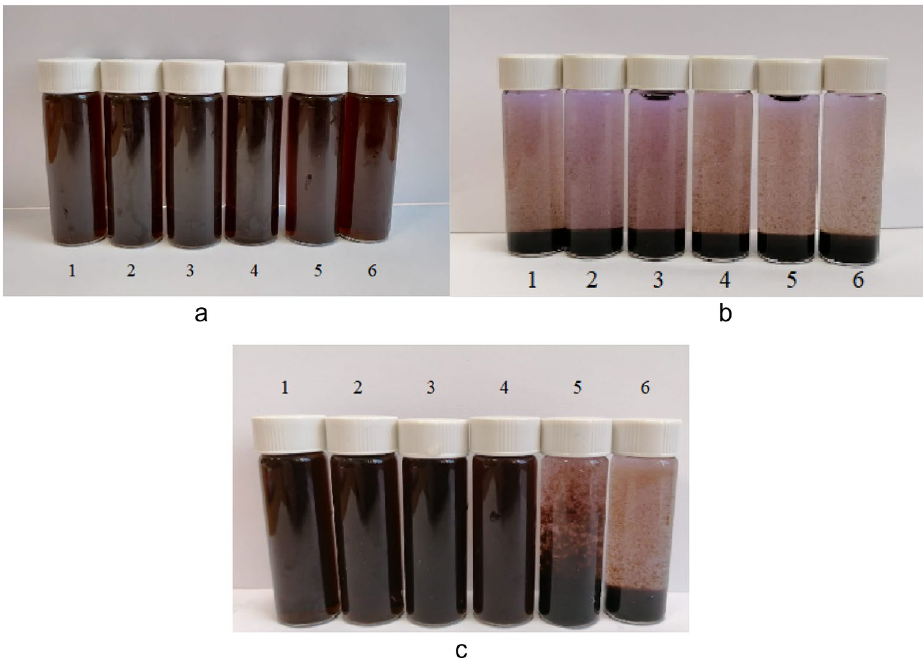
Figure 14. Photograph of CuO nanoparticles’ solutions with various electrolytes: ( a) – NaCl , ( b) – CaCl 2 , c – Na